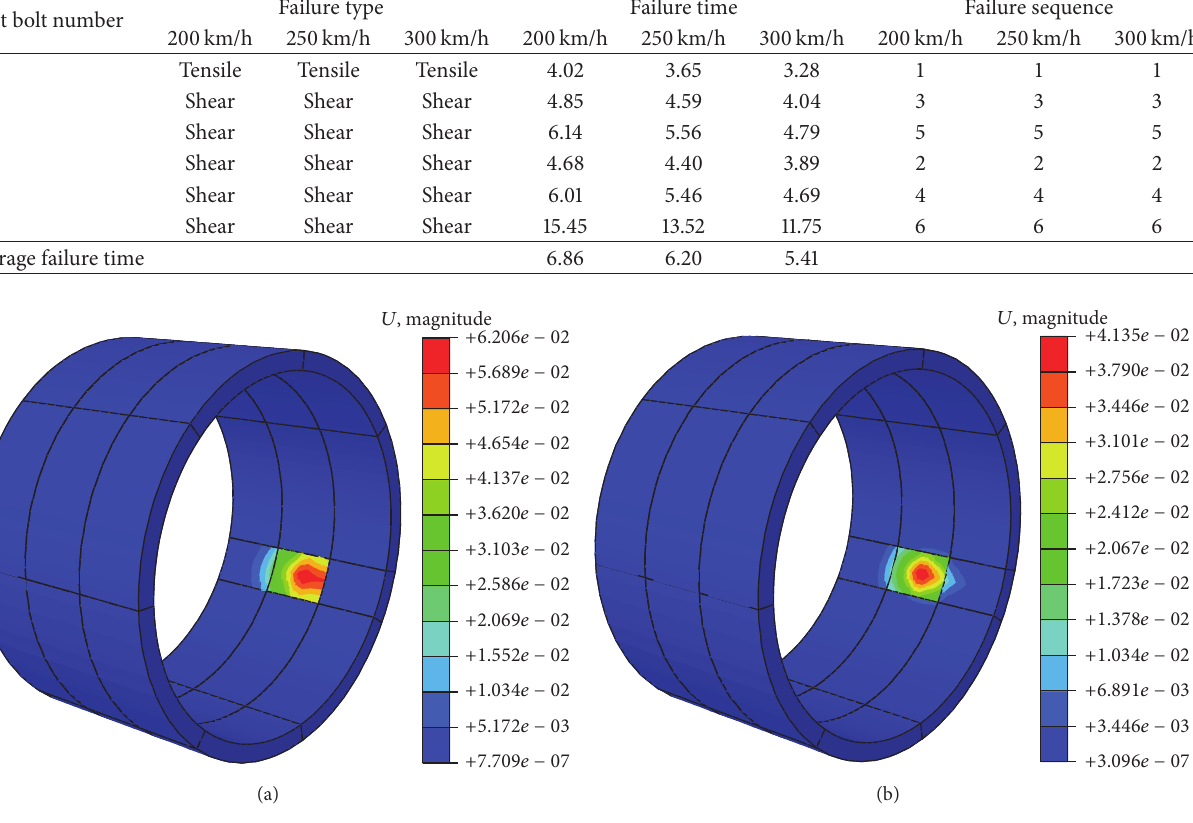
Figure 19: Displacement contours on the lining intrados in (a) Model I and (b) Model II.